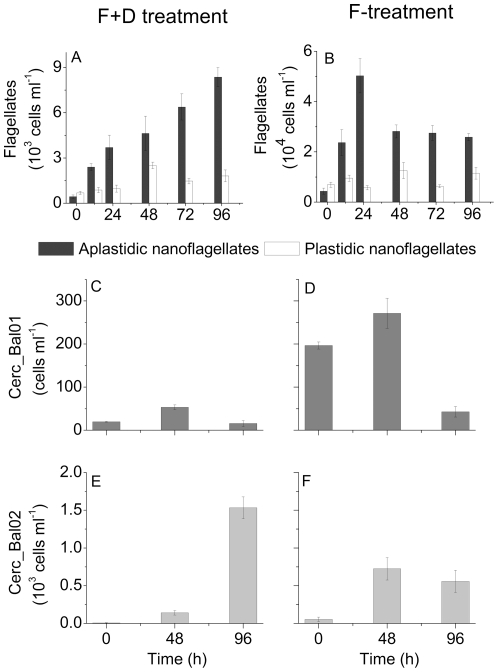
Development of NF in the experiments.Changes of the numbers of plastidic and aplastidic nanoflagellates (A–B), of cercozoan cells targeted by the probe Cerc_Bal01 (C–D); and of cercozoan cells targeted by the probe Cerc_Bal02 (E–F) in the F+D- (5 µm prefiltration and 1∶10 dilution) and F- (5 µm prefiltration) treatments. Error bars show standard deviation, based on the triplicate samples. Note that the Y-axis scale differs between the panels.